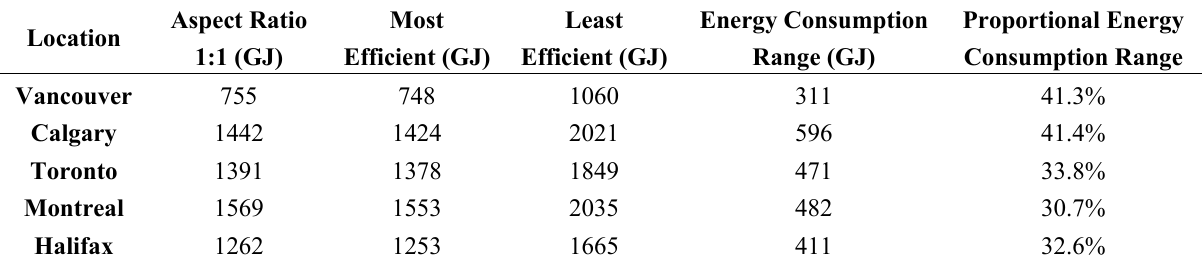
Table 6. Energy consumption range and proportional energy consumption